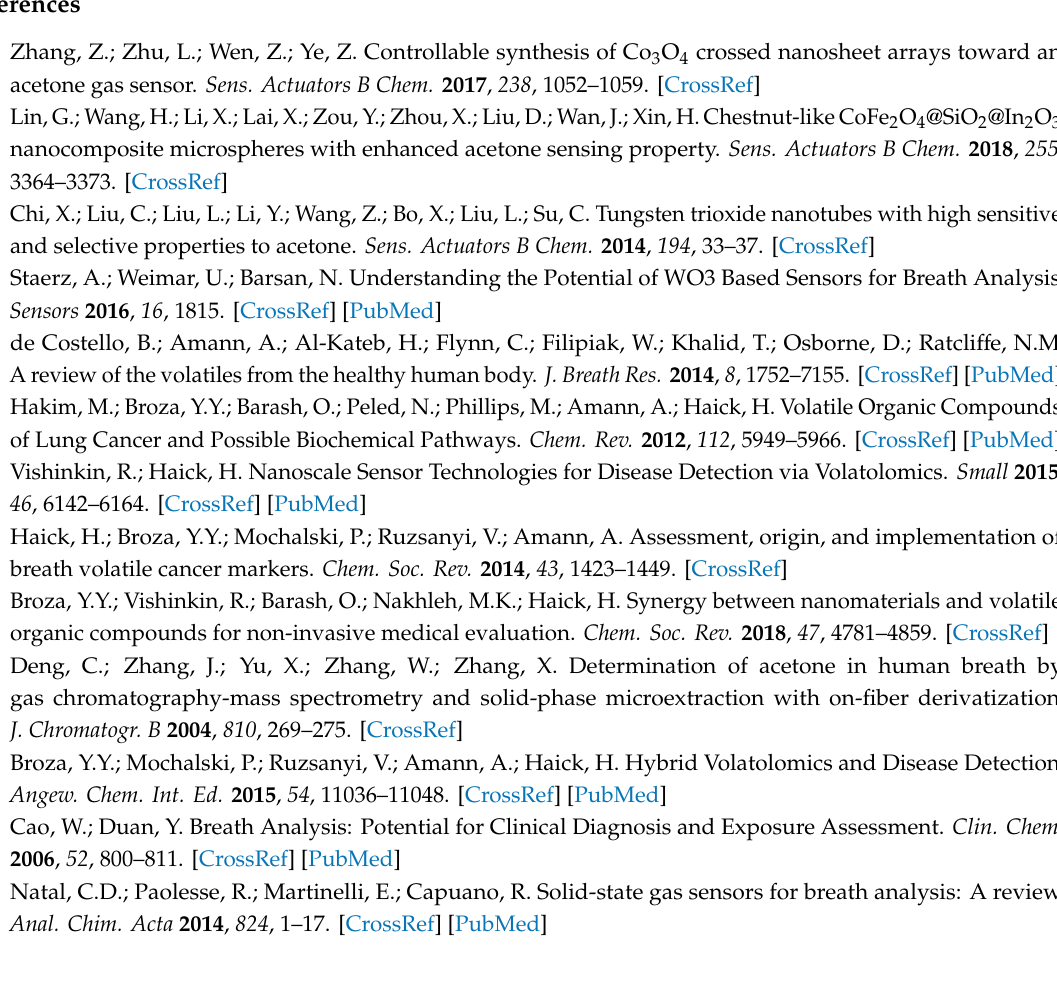
TGA image of the products, Figure S5: XRD and Raman spectra of samples annealed at di ff erent temperatures, Figure S6: SEM images of the hollow structure of the samples after annealing, Figure S7: the morphology doped with di ff erent amounts of Cr, Figure S8: XPS of samples annealed at di ff erent temperatures, Figure S9: I-V curve of sample, Figures S10–S11: base resistance of samples at di ff erent temperatures and